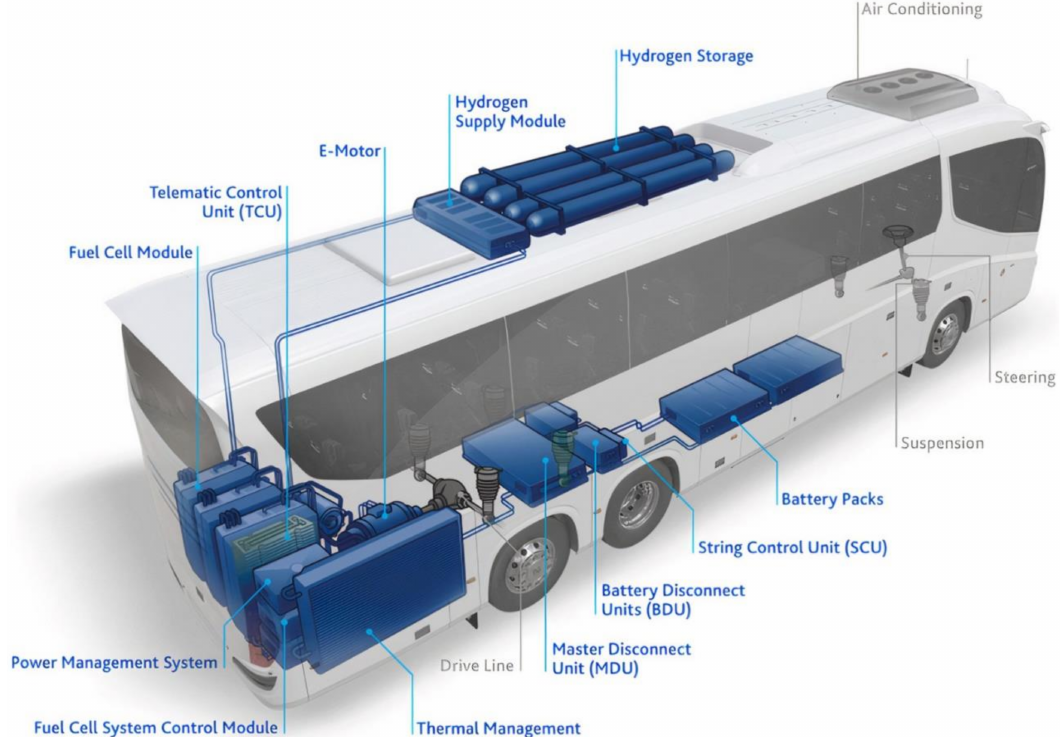
Figure 7. Components of fuel cell bus